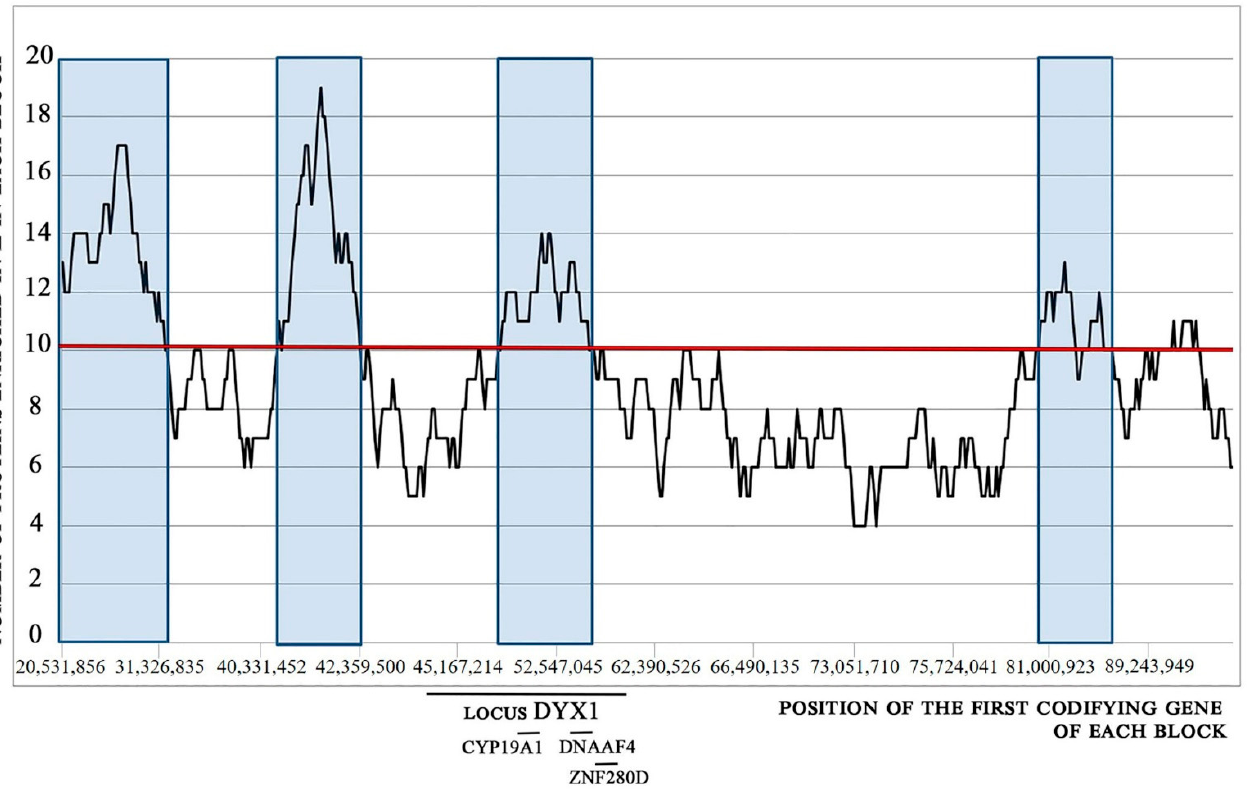
Figure 4. Chromosome walking and surfing analysis of chromosome 15. A block of 25 proteins was shifted along the whole chromosome. At each position of the block, the number of proteins having more than 49 E was calculated and reported on the ordinates. On the x-axis, the graph shows the position of the first codifying gene of each block (only a few values are displayed). The position of the locus and gene markers of dyslexia is indicated. The regions of chromosome codifying for many proteins with high content of E are highlighted.